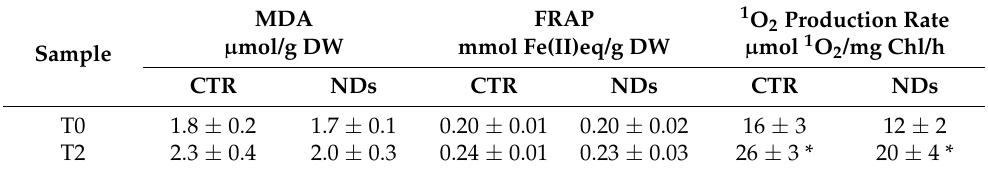
Table 3. MDA level, FRAP value, and 1 O 2 production rate in C. reinhardtii cultures pre-incubated with 40 µ g hNDs/mL for 24 h and in control cells exposed to 1000 µ mol/m 2 /s for 2 h. Means of 2 independent experiments with 3 biological replicates ( ± SD, n =